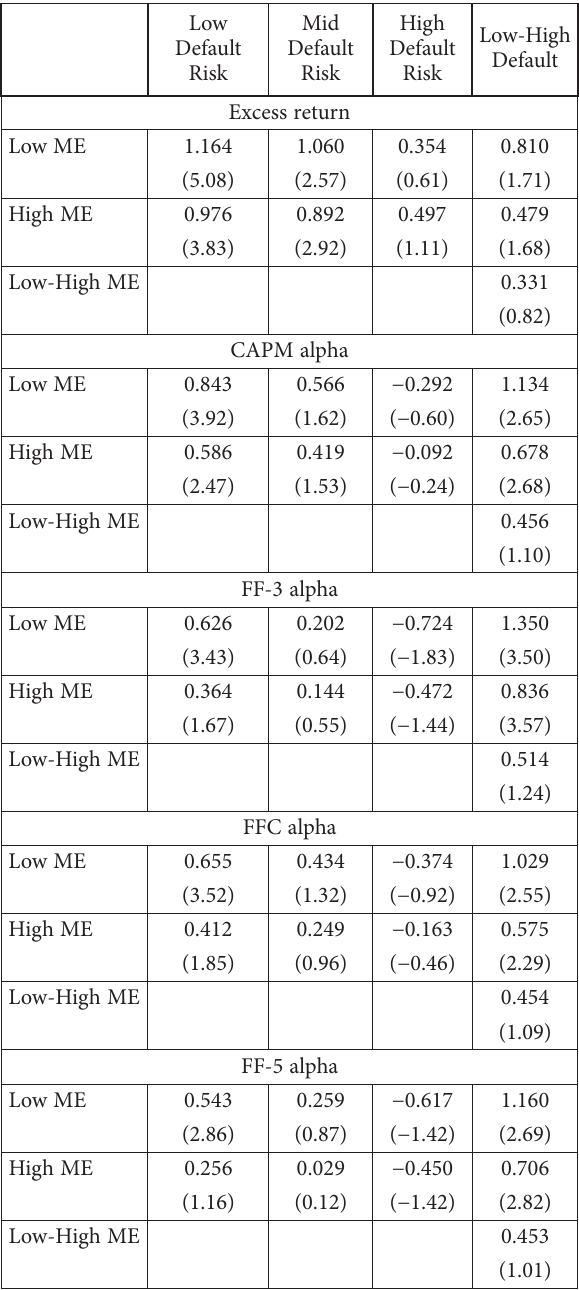
Table 3. Default risk premium and